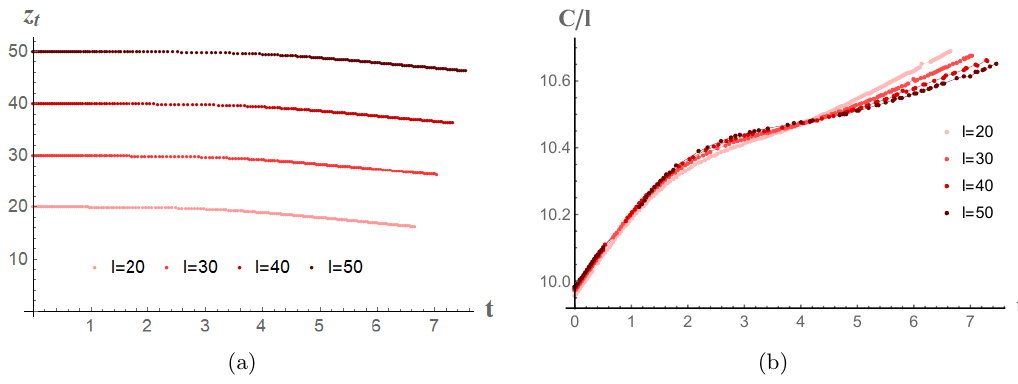
Figure 3 . Di(cid:11)erent red lines represent the subsystems with di(cid:11)erent half-width l . The evolution of the tip z t of the extremal surface is shown in 3(a) and the evolution of the HSC at the intermediate stage (which is near t = 4) is shown in 3(b). For l (cid:25) z t (cid:29) t , the rate of growth approaches zero as the half-width l goes to in(cid:12)nity. For large l , the numerical simulations are credible at the intermediate stage, but become out of control at the late-time